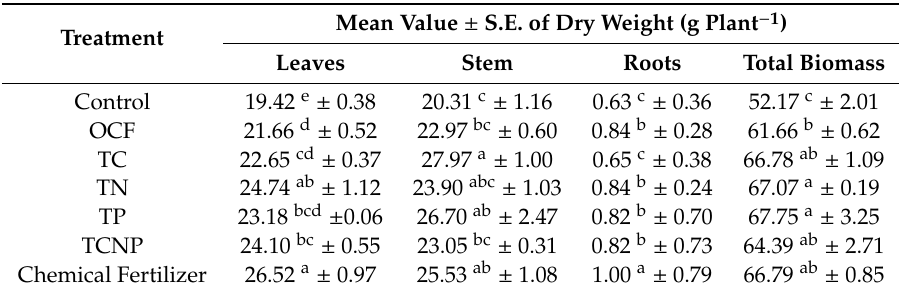
Table 2. Dry weight of leaves, stem and roots of maize plants at fifty-six days after